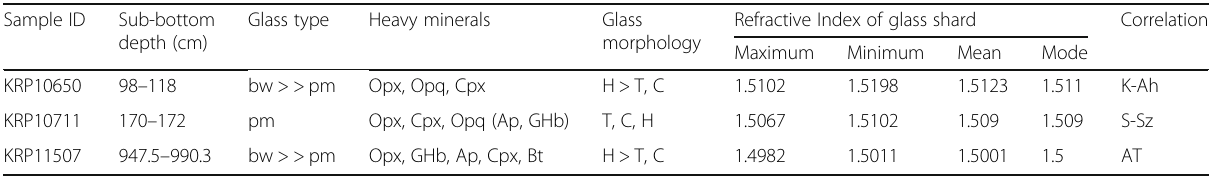
Table 1 Results of tephra analyses Sample ID